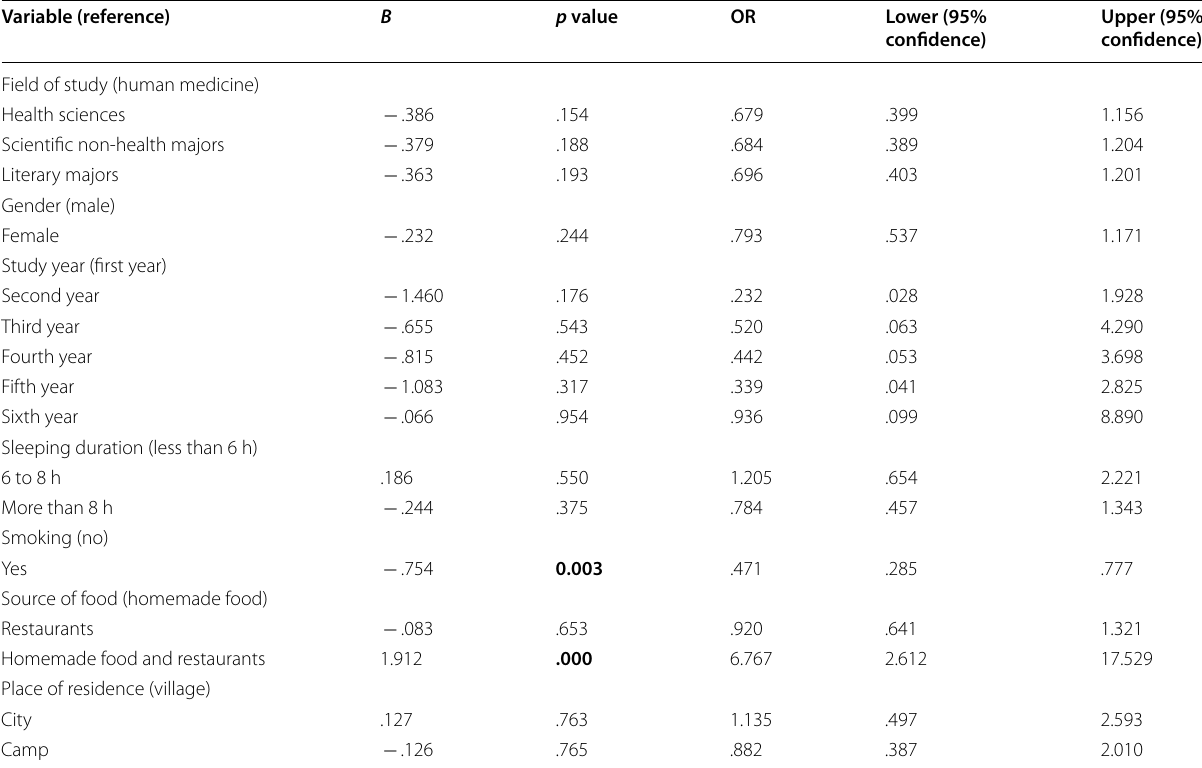
Table 6 Multiple logistic regression analysis of the associations between depression and influencing factors Variable (reference)